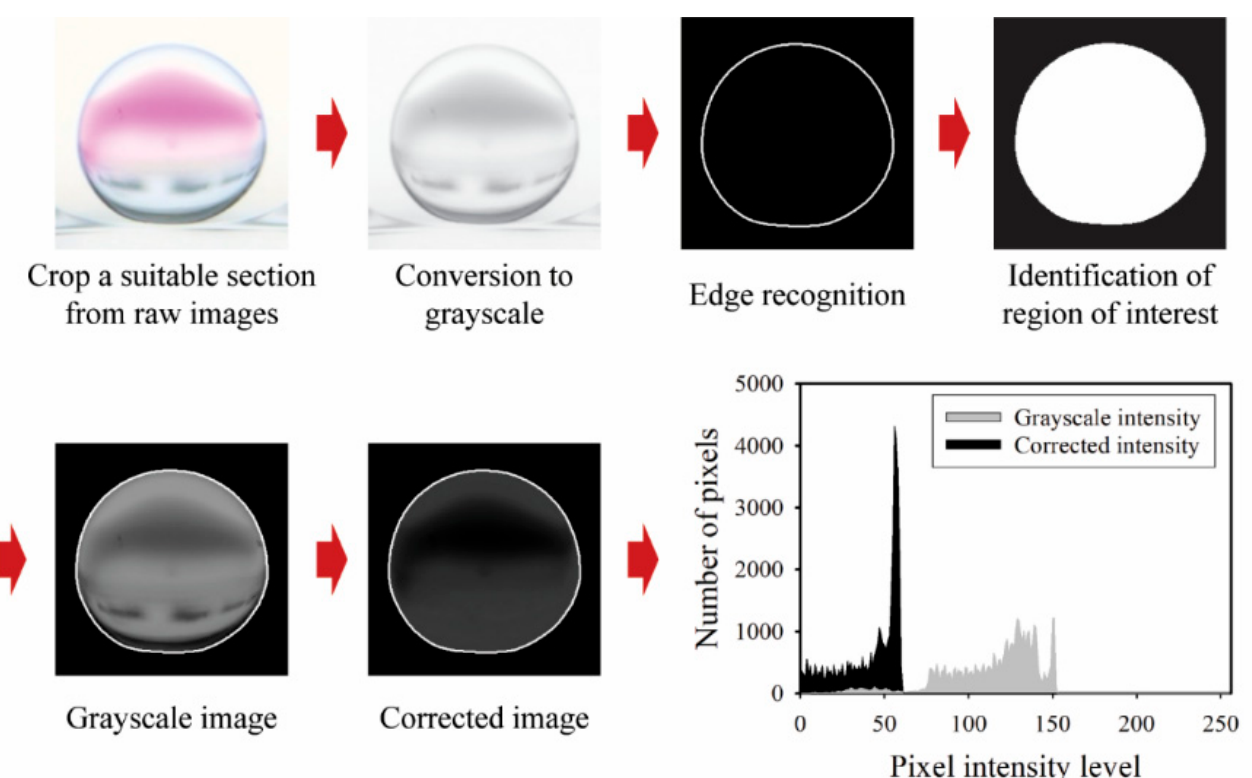
Figure 3. Schematic of the imaging process procedures used to determine the temporal variation in the mixing index within CCEP-actuated shaking droplets.